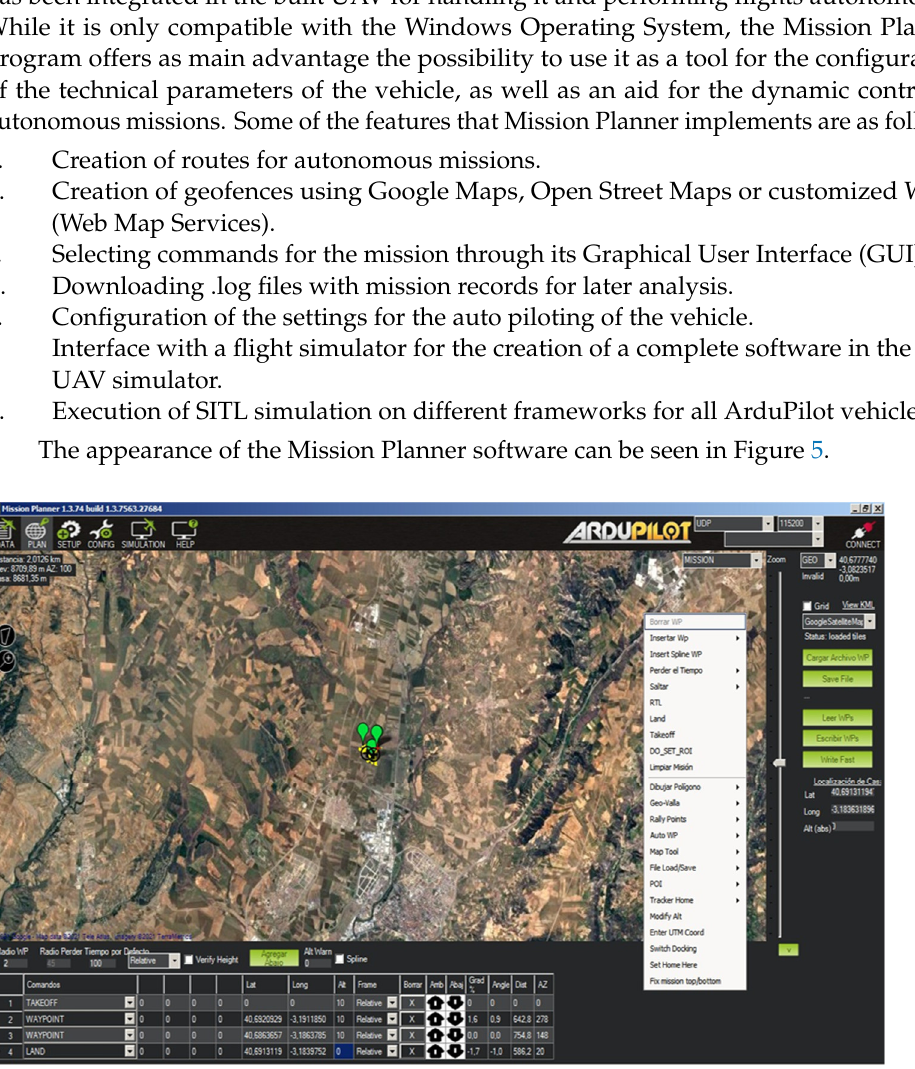
Figure 5. Example of Graphical User Interface provided by